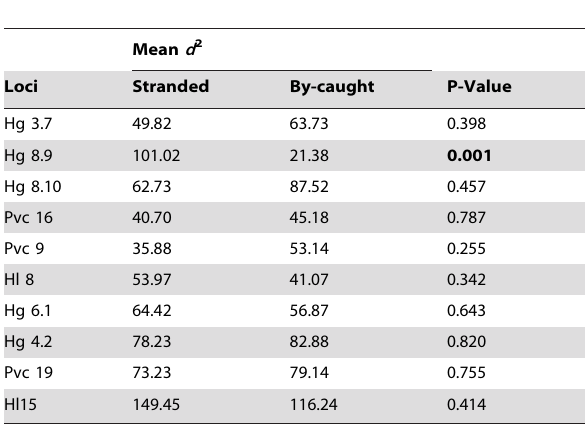
Table 3. Mean d 2 by locus and P-values for t-test between stranded and by-caught